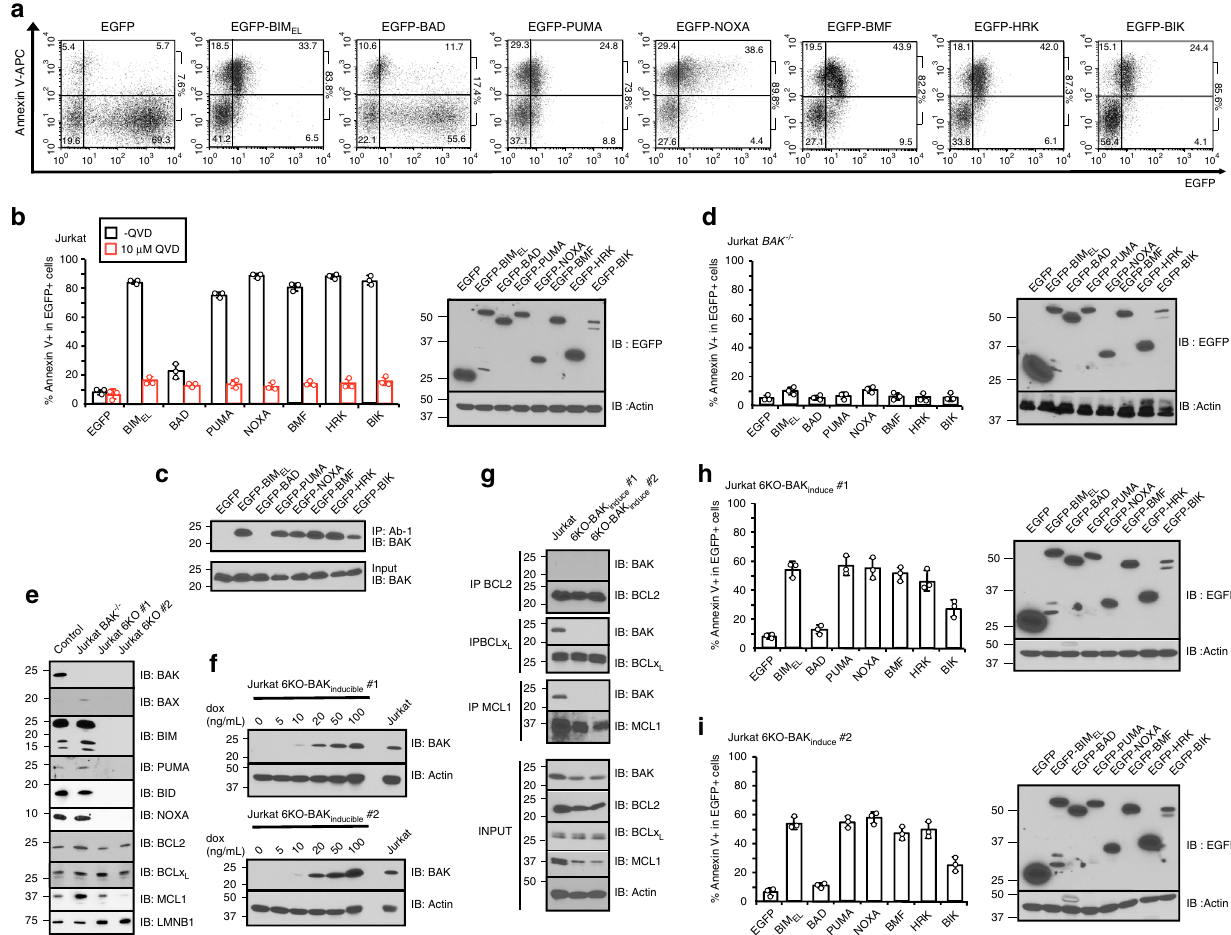
Fig. 3 BMF and HRK induce BAK/BAX-dependent apoptosis. a , b , d After WT a , b or BAK − / − d Jurkat cells were transfected with the indicated EGFP- tagged BH3-only proteins in the absence or presence of Q-VD-OPh for 24h, cells were harvested, stained with APC-conjugated Annexin V, and subjected to fl ow cytometry. A representative experiment a and summarized results b , d indicate the percentage of apoptotic cells (Annexin V + ) among successfully transfected cells (EGFP + ). Numbers at the right of the dot plots in a , indicate the percentage EGFP + cells (i.e., successfully transfected) that were Annexin V + , which was calculated as the ratio of events in the upper right to the sum of the lower right and upper right. c After WT Jurkat cells were transfected with indicated plasmids in the presence of Q-VD-OPh for 24h, cell lysates were incubated with BAK Ab-1 antibody. e Characterization of BIM − / − PUMA − / − BID − / − NOXA − / − BAK − / − BAX − / − HexaKO Jurkat cells by western blotting. f After two clones (#1 and #2) of Jurkat HexaKO (6KO) cells with inducible BAK were treated with the indicated concentrations of doxycycline (dox) for 16h, whole-cell lysates were probed with BAK antibody. g – i After the two clones of Jurkat HexaKO with BAK inducible plasmid were induced with 10ngml − 1 doxycycline for 16h, cells were lysed, immunoprecipitated with indicated antibodies and blotted for BAK. Jurkat cells served as a positive control g . Meanwhile, both clones h , i were transfected with EGFP-tagged BH3-only plasmids for 24h, harvested, and stained with APC-conjugated Annexin V. The percentages EGFP + cells that were Annexin V + are indicated. Right panels in b , d , h , i , whole-cell lysates subjected to immunoblotting. Error bars: mean ± S.D. of three independent experiments. Source data are provided as a source data fi